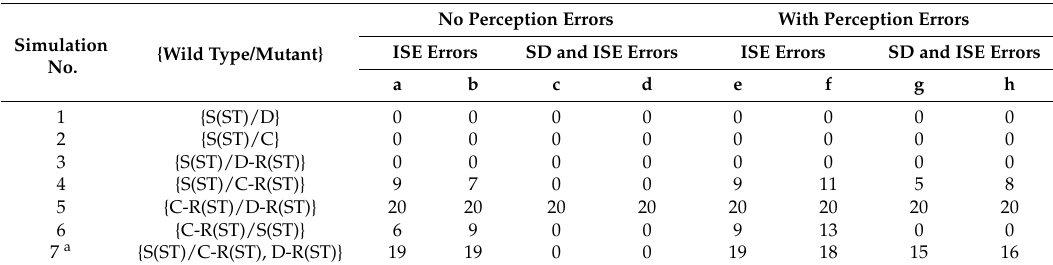
Table 5. Frequency of a successful invasion under